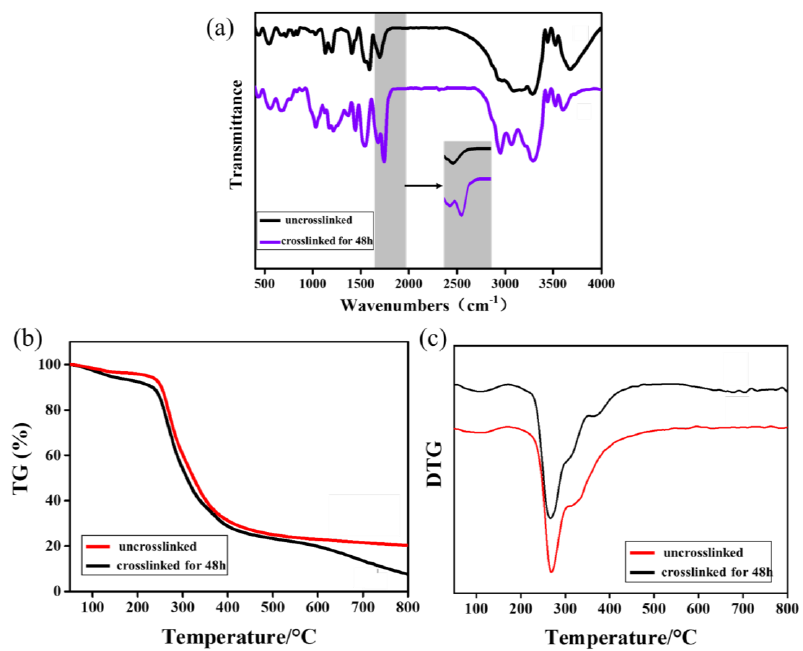
Figure 4. ( a ) FTIR spectra of γ -PGA/keratin before and after cross-linking; ( b ) TG of ENSs before and after cross-linking; ( c ) DTG of ENSs before and after cross-linking.